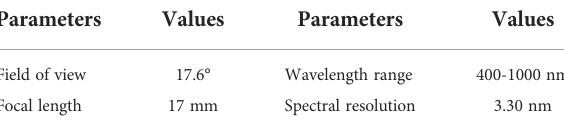
TABLE 1 Main parameters of the Pika L hyperspectral